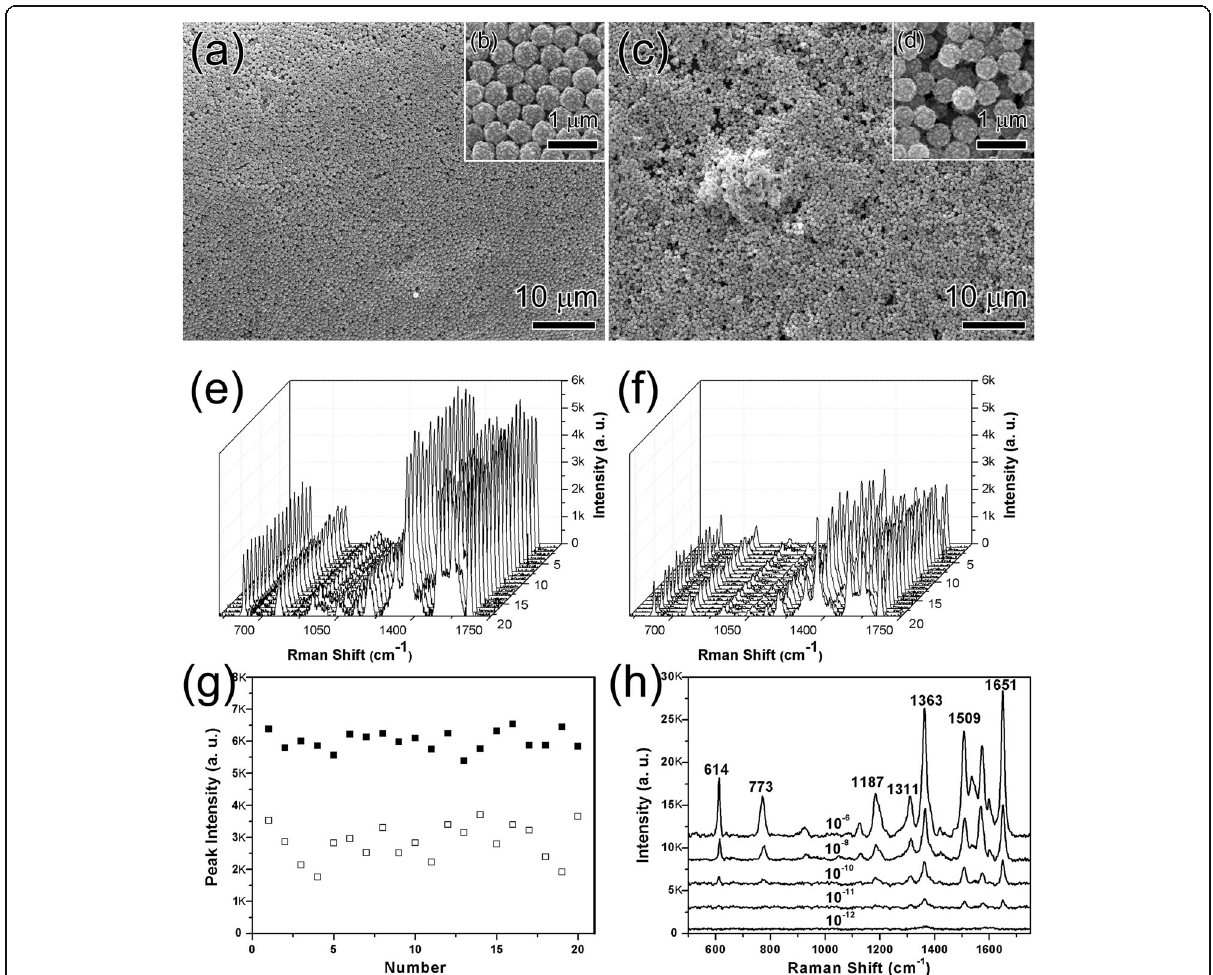
Fig. 4 The SEM images ( a ), SERS spectra ( b ), and photocatalytic performance ( c ) of FOSTA composite microspheres at different reaction times (I) 15, (II) 20, (III) 25, and (IV) 30